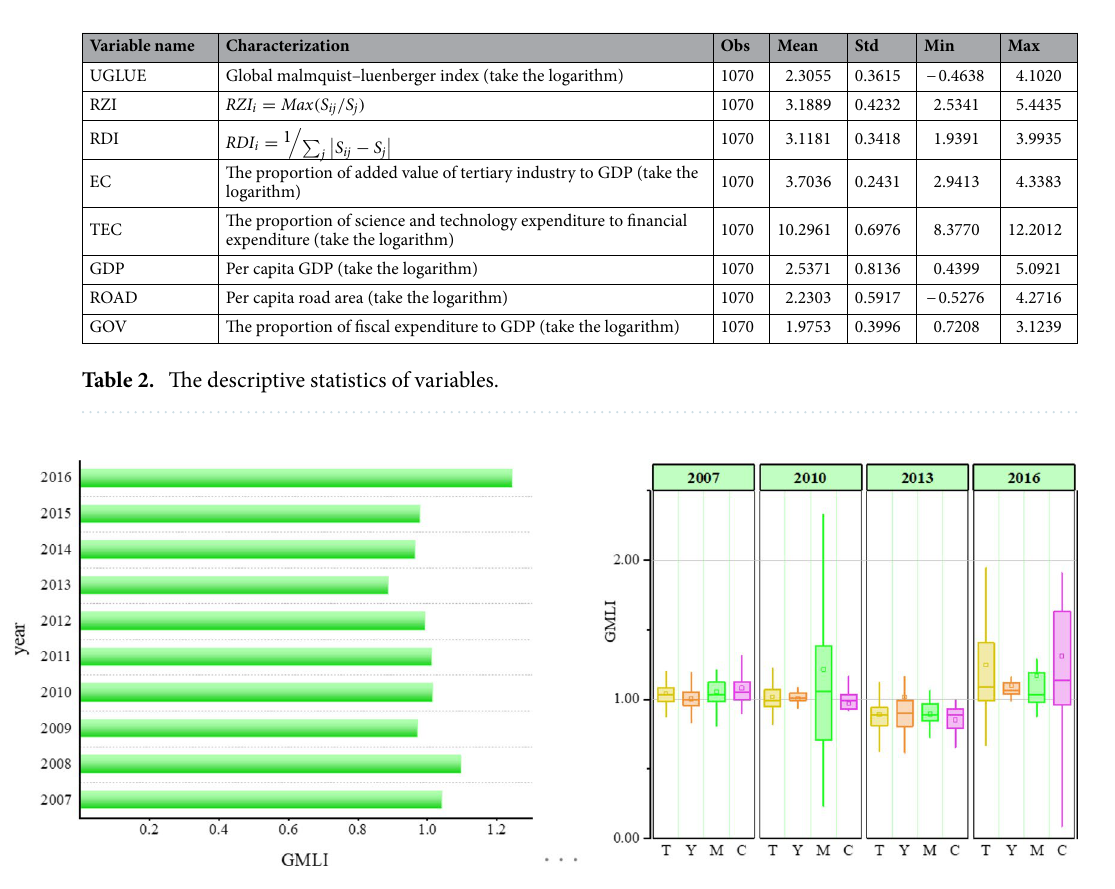
Figure 3. Average GMLI of UGLUE in YREB from 2007 to